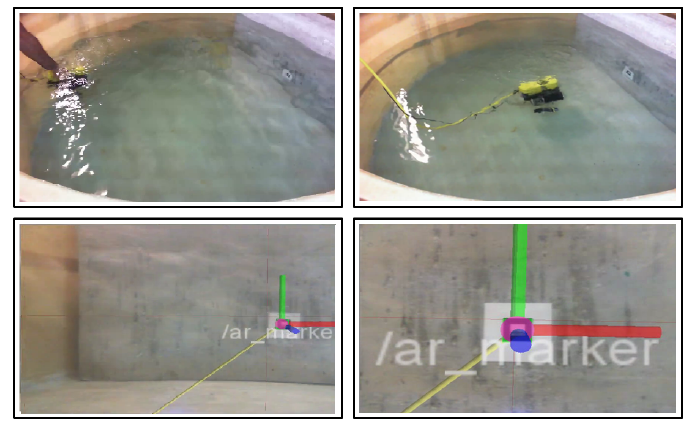
Figure 5. Experimental setup. The underwater robot at the initial and desired configuration with respect to a visual marker. Vehicle’s view at initial and the desired position, respectively, c (cid:13) 2014 IEEE